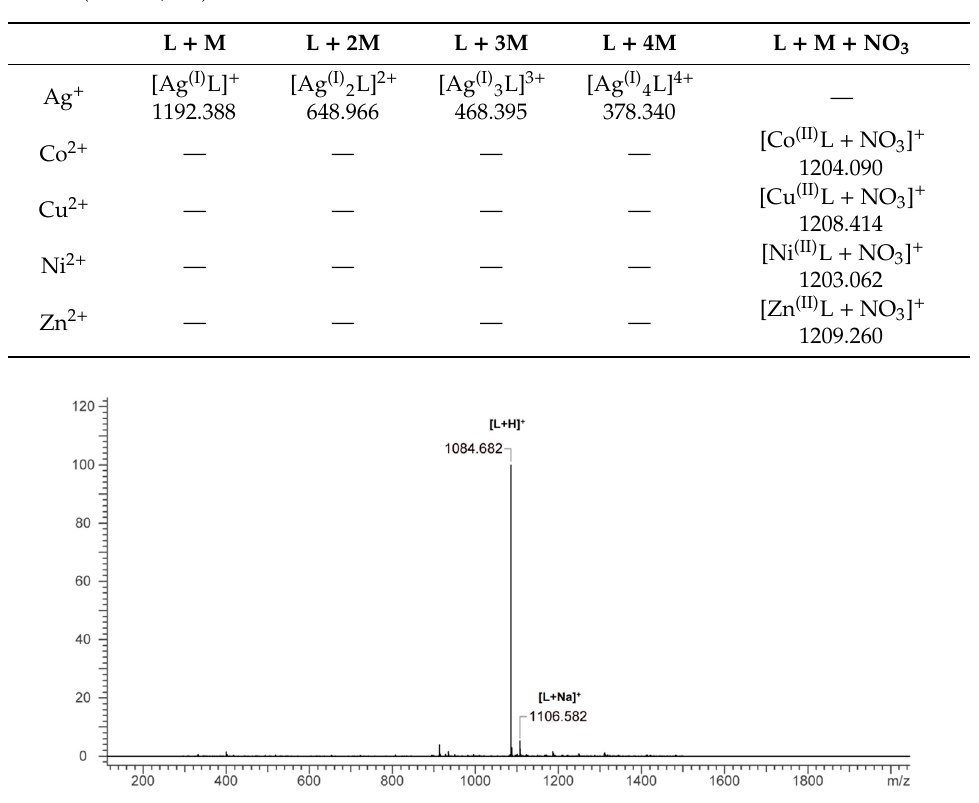
Figure 5. The ESI mass spectrum of investigated ligand L in